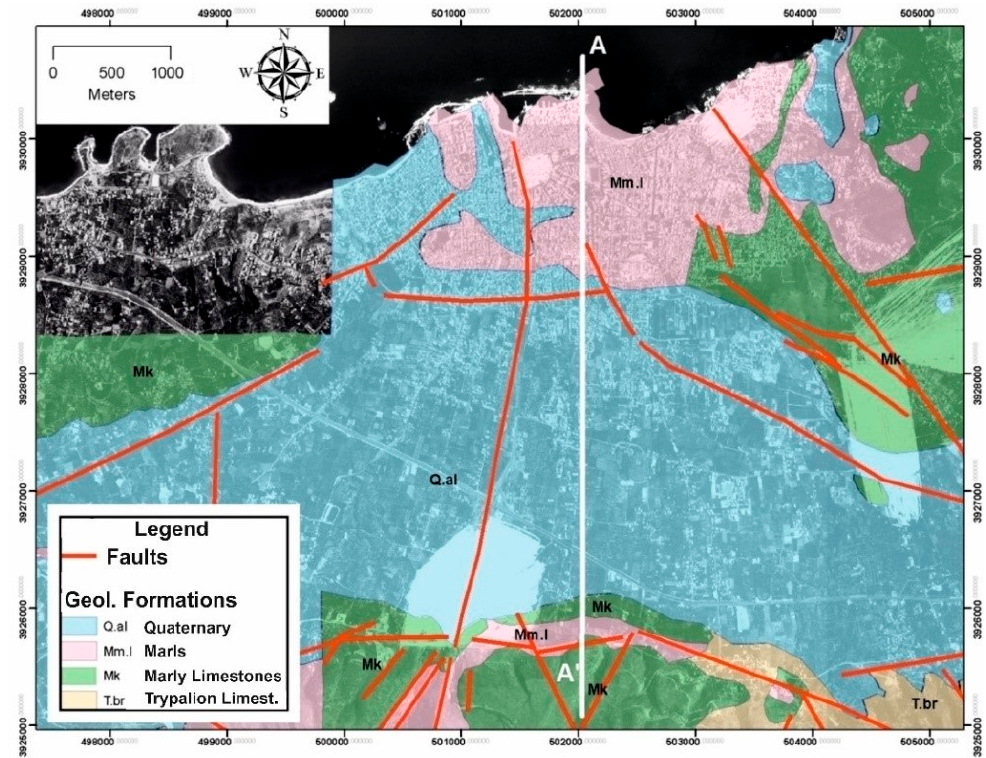
Appl. Sci. 2021 , 11 , x FOR PEER REVIEW Figure 1. Geology and main faults close to Chania (adopted from [33]). Figure 1. Geology and main faults close to Chania (adopted from [33]).